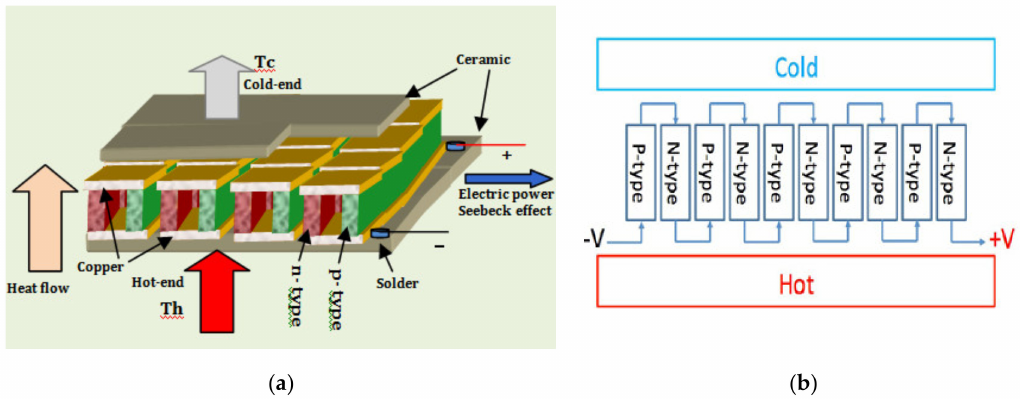
Figure 1. ( a ) Model of a thermoelectric generator (TEG) showing the details ( b ) schematic diagram of thermoelectric couples in a TEG.